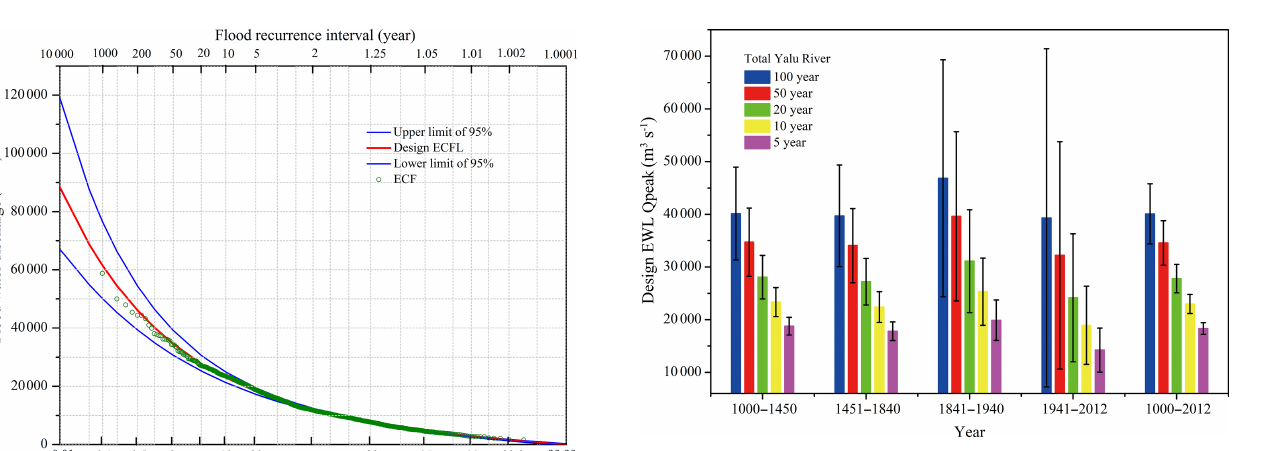
Figure 8. Estimated peak discharges of the different flood recur- rence intervals for the Yalu River based on simulated peak dis- charges during five periods combined with the GEV statistical